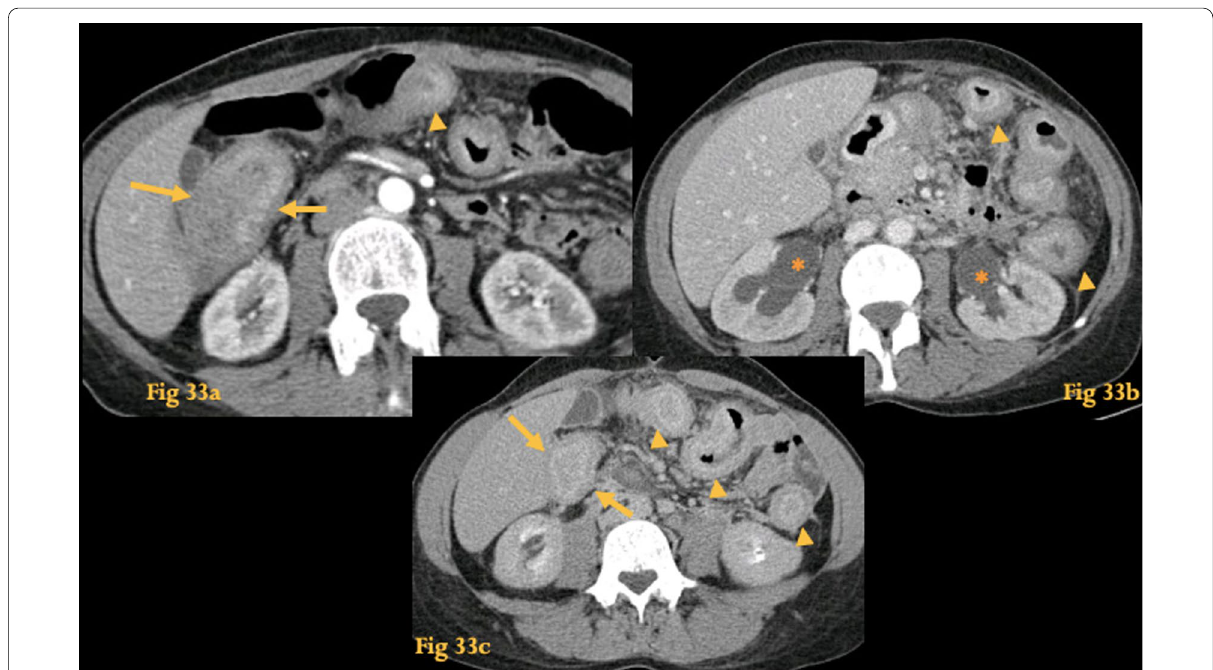
Fig. 33 Vasculitis (lupus). Abdominal CT of a patient with systemic lupus erythematosus and antiphospholipid syndrome ( a ). There is evidence of multifocal thickening of several bowel loops with a target appearance (arrowheads), including the stomach, colon and D2 (arrows). Note also bilateral hydronephrosis (asterisks in b ). Abdominal CT ( c) of the same patient following 3 weeks of steroid treatment with no clinical improvement revealed resolution of some of the previous affected segments, while other bowel segments showed wall thickening for the first